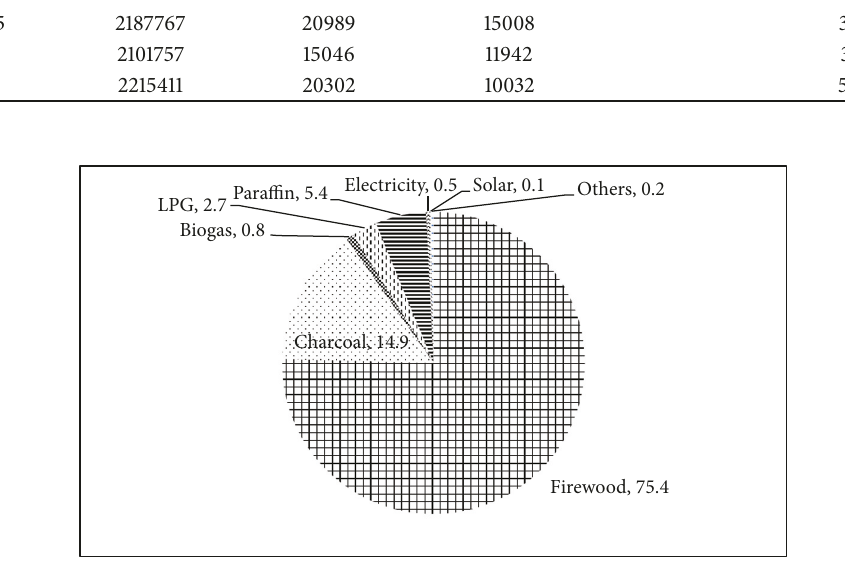
Figure 1: Percentage distribution of households by source of cooking fuel in Kirinyaga